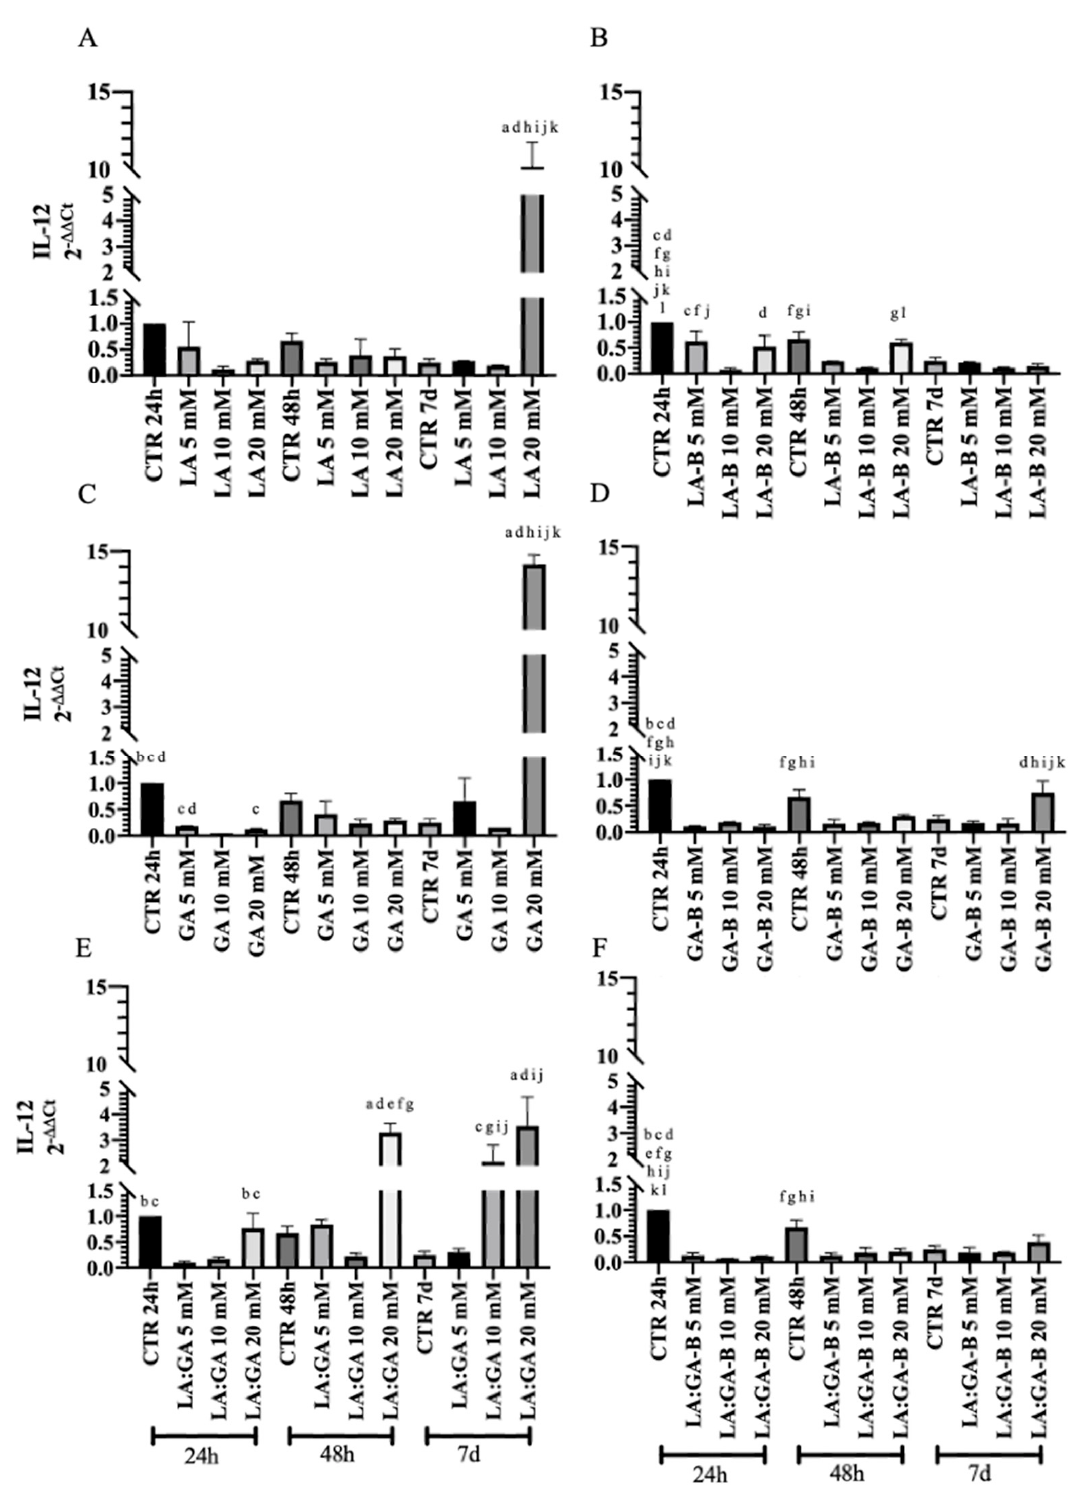
Figure 12. IL-12 expression after the treatments with non-buffered ( A ) LA, ( C ) GA, and ( E ) LA:GA and with the equivalents buffered ( B ) LA-B, ( D ) GA-B, and ( F ) LA:GA-B solutions at different concentrations and at different time points. Significant difference legend: a vs. CTR 24 h; b vs. 5 mM 24 h; c vs. 10 mM 24 h; d vs. 20 mM 24 h; e vs. CTR 48 h; f vs. 5 mM 48 h; g vs. 10 mM 48 h; h vs. 20 mM 48 h; i vs. CTR 7 d; j vs. 5 mM 7 d; k vs. 10 mM 7 d; and l vs. 20 mM 7 d.